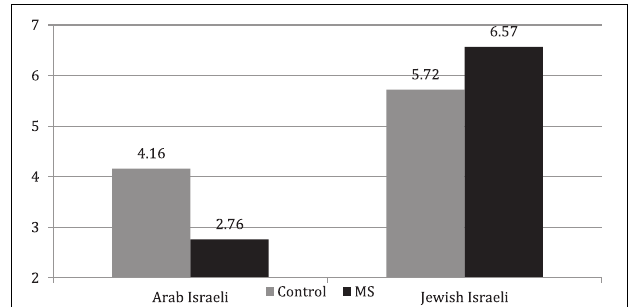
FIGURE 1 | Participants’ willingness to help a Jewish Israeli vs. Arab Israeli